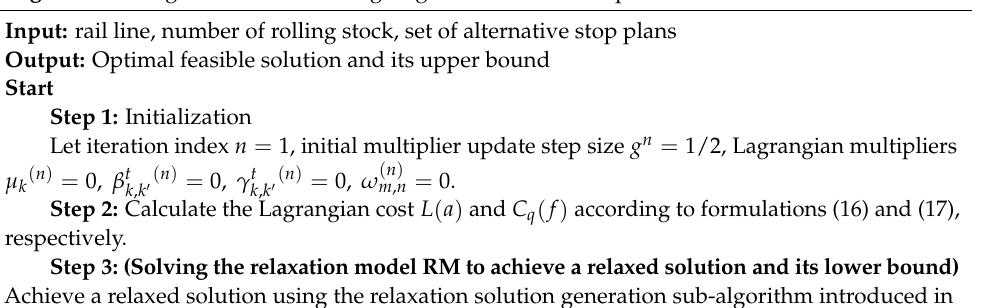
Algorithm 1: Algorithm based on Lagrange relaxation